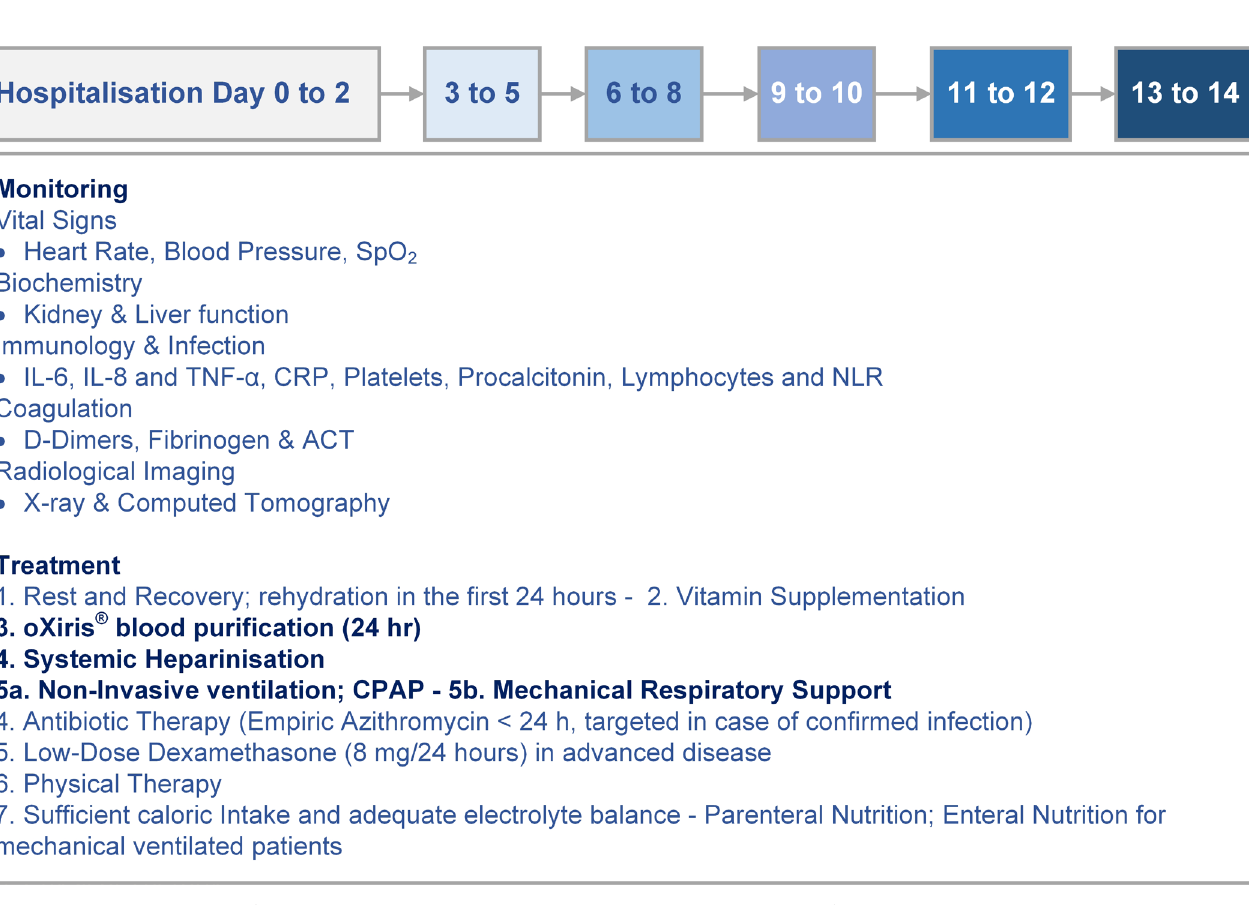
Fig. 2 - Treatment protocol for coronavirus disease 2019 patients. In addition to blood purification, systemic heparinisation, and physical therapy under continuous positive airway pressure (CPAP), the general care protocol consisted of rest and recovery; sufficient caloric intake and adequate electrolyte balance; aggressive rehydration in the first 24 hours; parenteral, enteral nutrition for mechanically ventilated patients; low- dose Dexamethasone therapy (8 mg/24 hours), antibiotic therapy, and biochemical and chest X-ray imaging for monitoring. ACT=activation clotting time; CRP=C-reactive protein; IL=interleukin; NLR=neutrophil-to-lymphocyte ratio; SpO2=oxygen saturation; TNF-α=tumour necrosis factor alpha (range 27–83). The patients were referred to us from